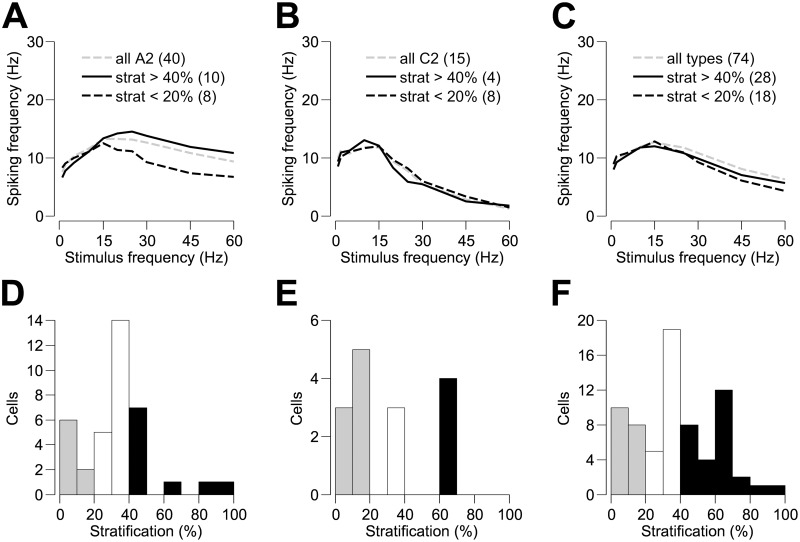
The effect of dendritic stratification depth on the frequency response of retinal ganglion cells.Panels (A) and (B) show the mean frequency response of A2 and C2 RGC types, respectively. Within each RGC type, cells are grouped and their frequency responses averaged according to the depth of their stratification within the inner plexiform layer (IPL). Cells stratifying in the inner-most sub-lamina (>40% of the IPL thickness) are shown in black and those at the outer-most extreme of the IPL (<20% of the IPL thickness) are shown in grey. For comparison, the frequency response, averaged over all cells of a given type, irrespective of stratification depth, is shown by the dashed line. Panel (C) shows the mean frequency response over all non-bistratified RGCs in our sample, grouped according to the depth of their stratification within the IPL but without regard to their morphological cell type. Conventions are the same as in (A) and (B). Panels (D–F) show distributions of dendritic stratification depth, as a proportion of IPL thickness, for the cell groups shown in panels (A–C), respectively.